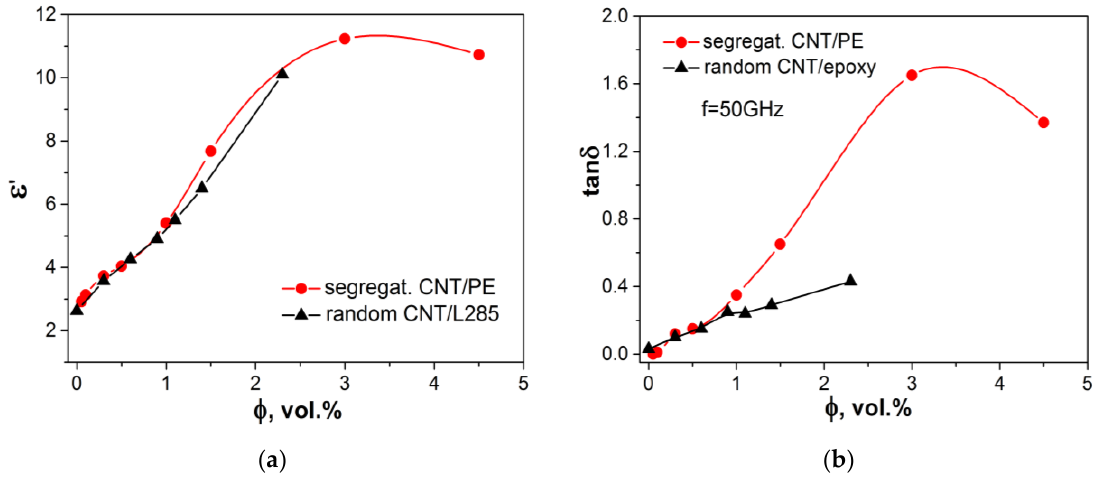
Figure 6. Permittivity 𝜀 𝑟 ′ (a) and dielectric loss tangent 𝑡𝑎𝑛𝛿 (b) for segregated CNT/PE CMs and random CNT/L285 CMs.